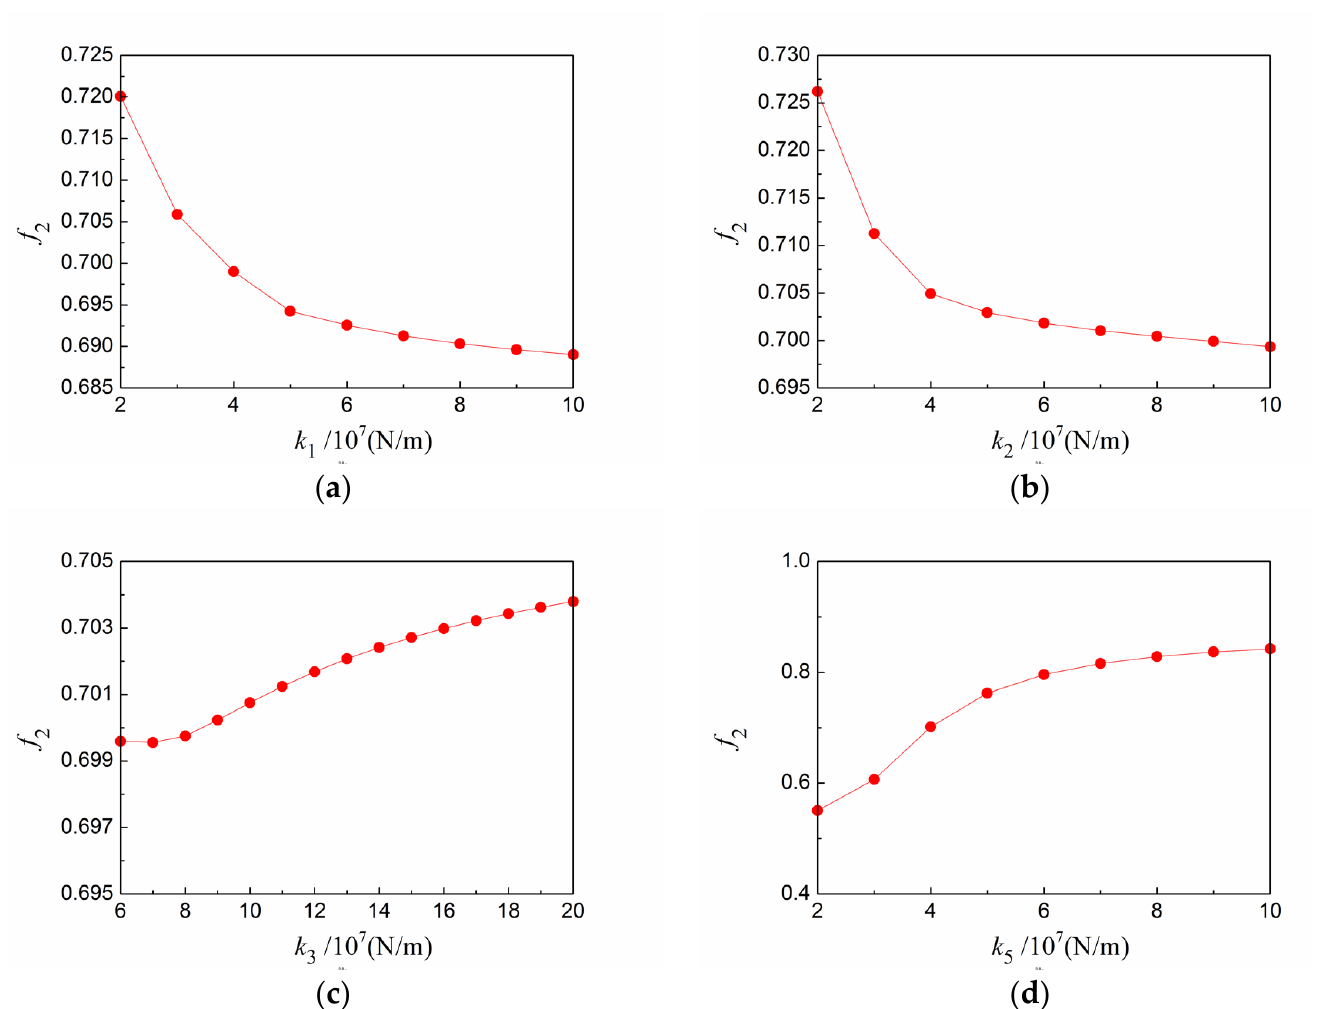
Figure 14. Effect of stiffness change of each support on f 2 . ( a ) Effect of support 1 stiffness on f 2 ; ( b ) effect of stiffness of support 2 on f 2 ; ( c ) effect of stiffness of support 3 on f 2 ; ( d ) effect of stiffness of support 5 on f 2 .